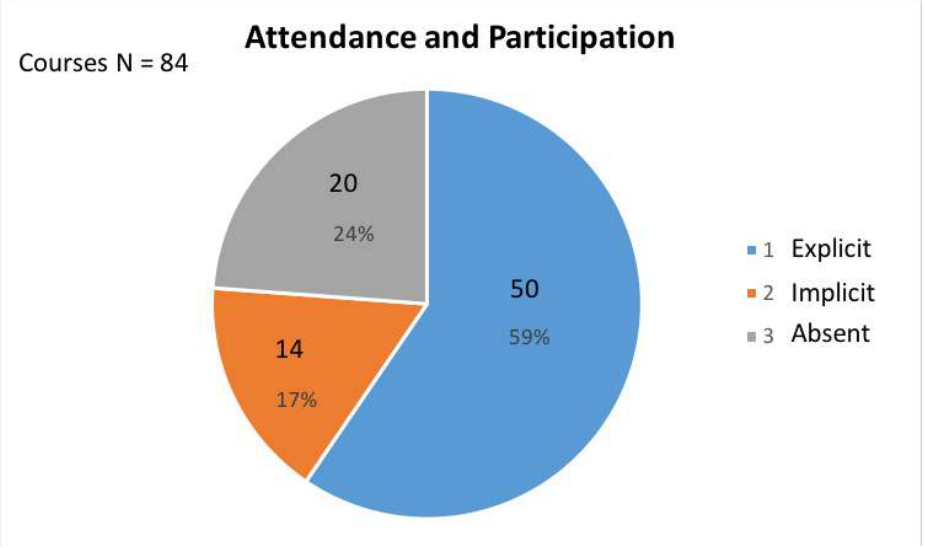
Figure 6: Compulsory attendance and participation